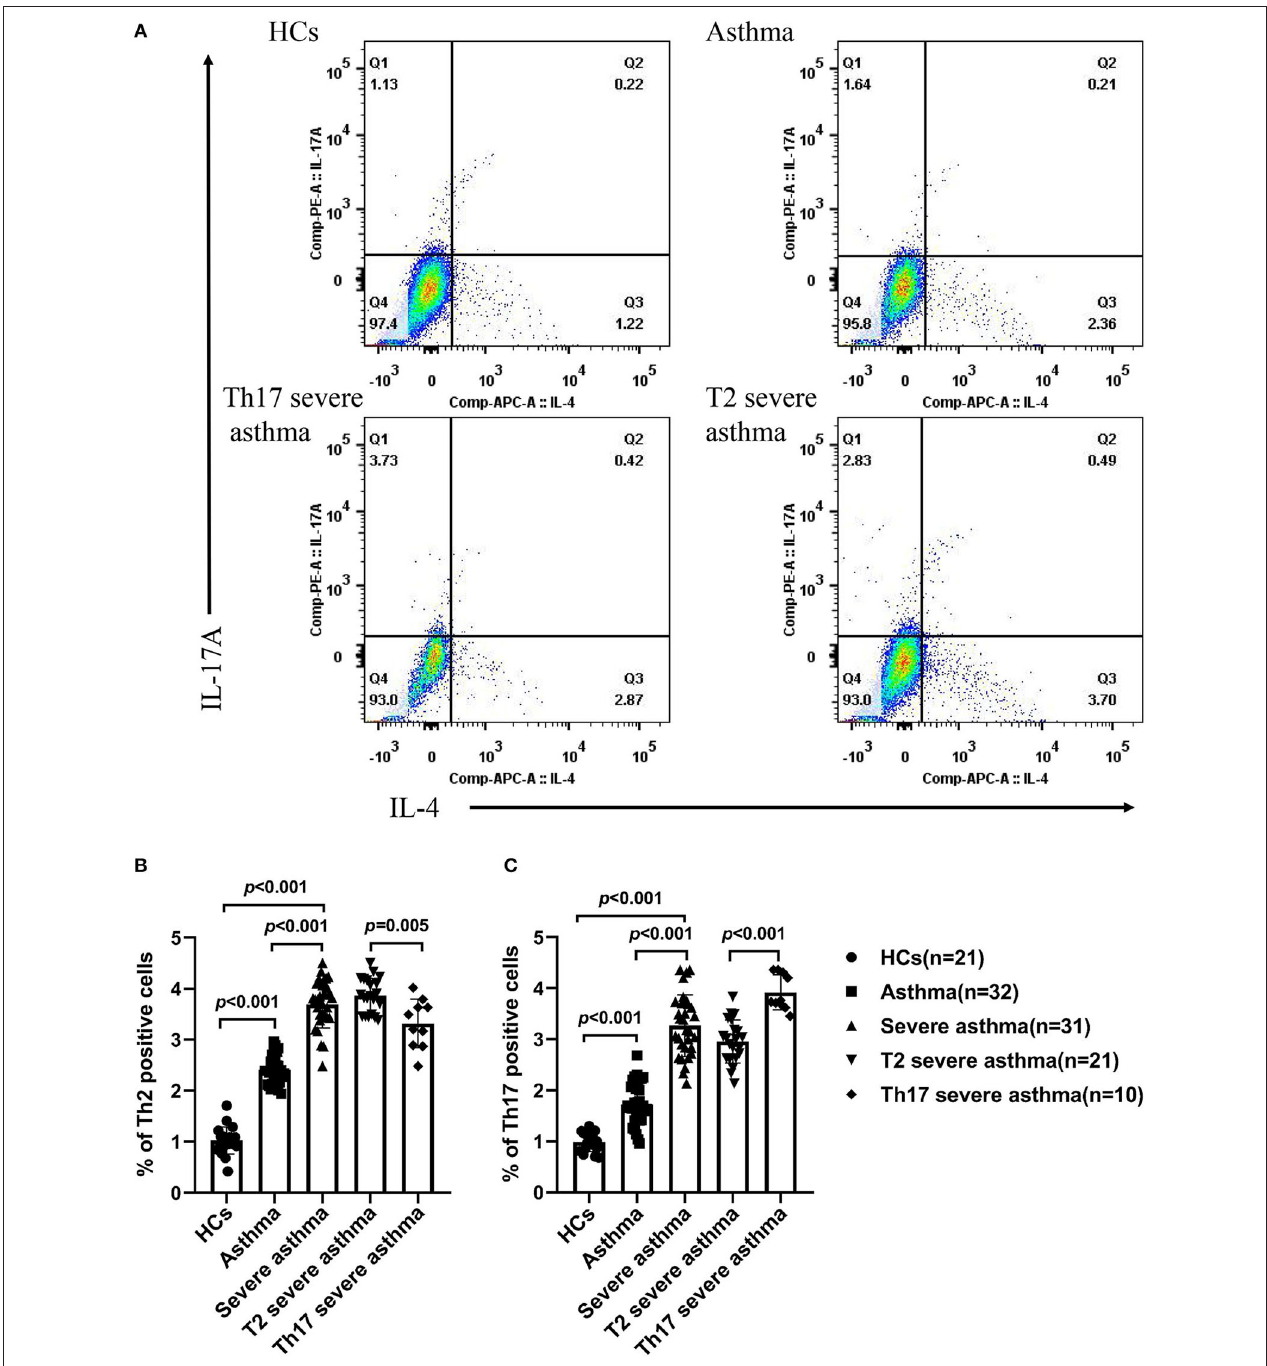
FIGURE 3 | Percentage of Th2 and Th17 cells in the peripheral blood of different groups. (A) Flow cytometry used to measure the percentage of Th2 and Th17 cells in the peripheral blood of different groups. The percentage of Th2 cells (B) and the percentage of Th17 cells (C) were compared for HCs and patients with asthma, severe asthma, T2 severe asthma and Th17 severe asthma. Comparisons among the groups were performed by Kruskal-Wallis test followed by Dunn’s multiple comparisons test. P < 0.05 was considered statistically significant. Th2, T-helper cell type 2; Th17, T-helper cell type 17.